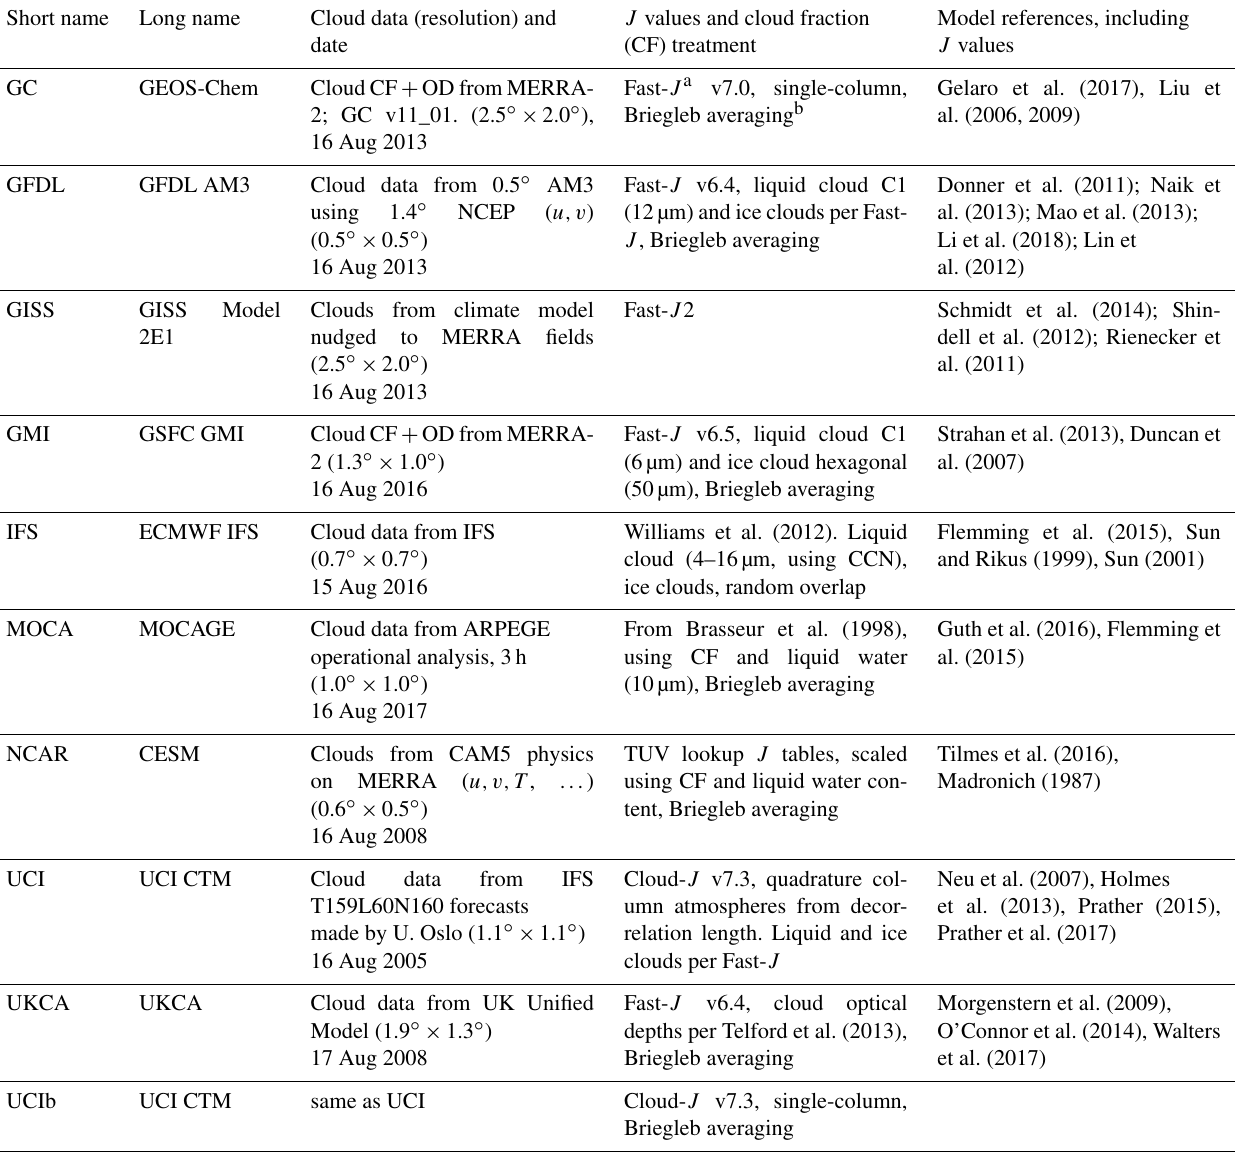
Table 1. Modeling photolysis and cloud